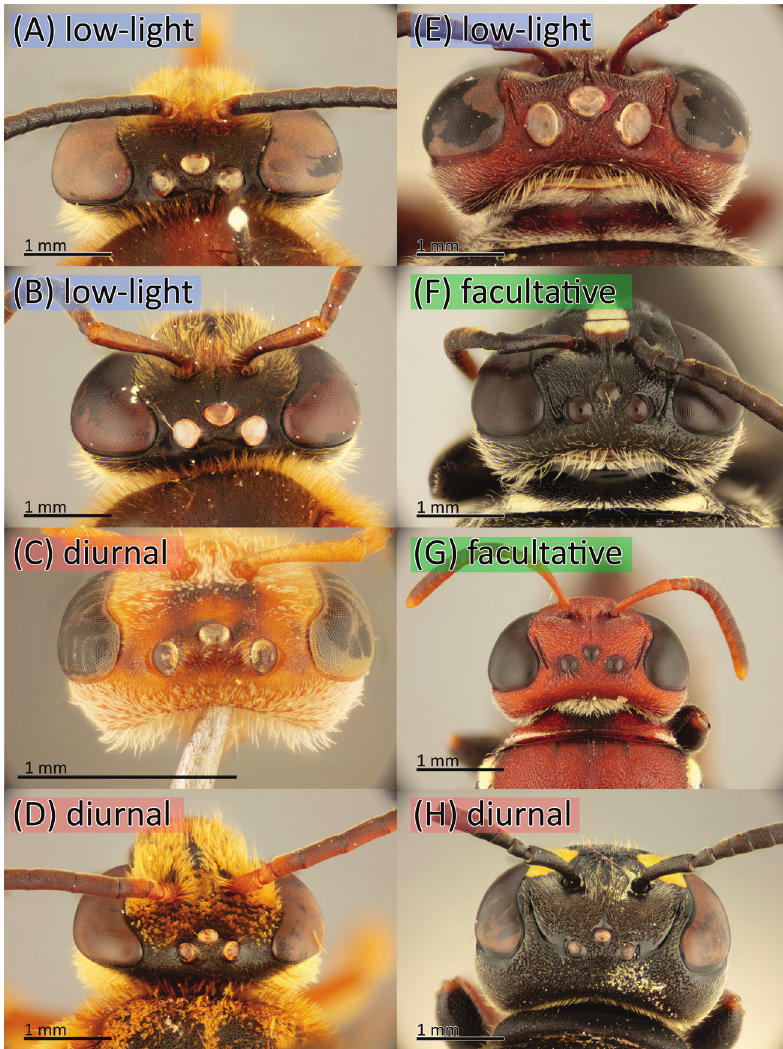
Figure 5. Dorsal head of some included species and related species for comparison of ocelli size A male and B female Reepenia bituberculata (Halictidae: Nomiinae) collected in low-light conditions C Lasioglos- sum ( Chilalictus ) ochroma (Halictidae: Halictinae), a species that has been hypothesised to be adapted to low-light conditions due to loss of pigment D Mellitidia tomentifera (Halictidae: Nomiinae), a bee in the same subfamily as Reepenia without enlarged ocelli E Meroglossa gemmata (Colletidae: Hylaeinae) F M. impressifrons penetrata (Colletidae: Hylaeinae) G M. eucalypti (Colletidae: Hylaeinae) H Hylaeus ( Analastoroides ) foveatus (Colletidae: Hylaeinae) a bee in the same subfamily as Meroglossa that lacks en- larged ocelli. Meroglossa gemmata has enlarged ocelli, consistent with adaptation to low-light conditions, comparable in relative size to R. bituberculata . The other two Meroglossa spp. ( M. impressifrons penetrata and M. eucalypti ) do not show such extreme morphological features compared to other members of the genus examined by Houston (1975), but are facultative low-light adapted. When compared to repre- sentatives from their respective subfamilies both Meroglossa (Hylaeinae) and Reepenia (Nomiinae) have relatively enlarged ocelli. Colours refer to those for each behavioural state in Fig.